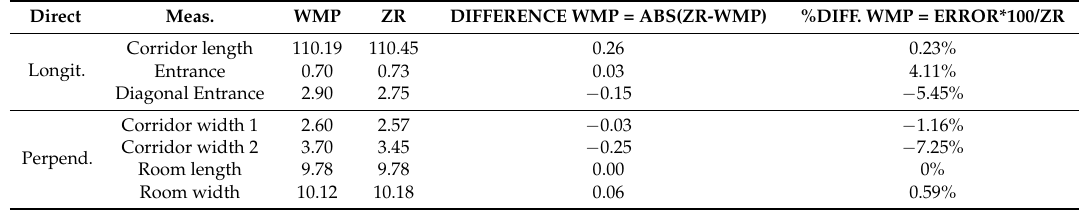
Table 9. Results of the 2D measurements for Case study 4, in meters.